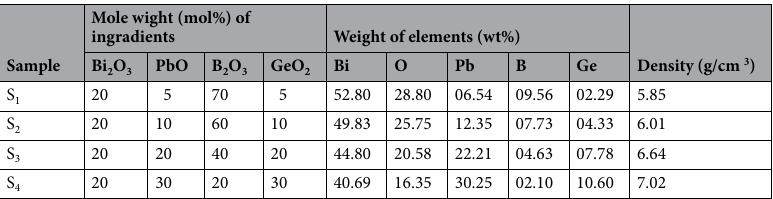
Table 1. Chemical compositions and densities of studied